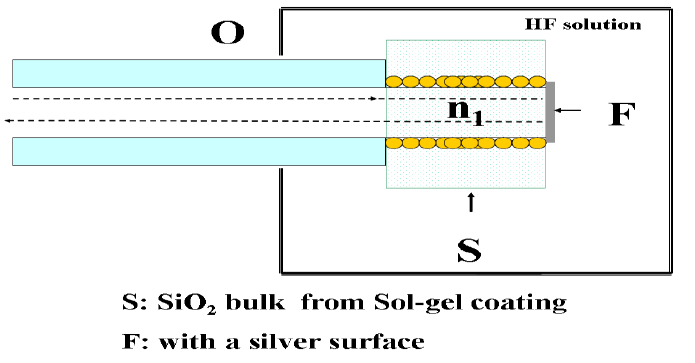
Figure 2. Schematic diagram of the reflection-based LSPR fiber-optic probe ( O ), with a silver surface ( F ), immersed in fluid vessel, containing a HF